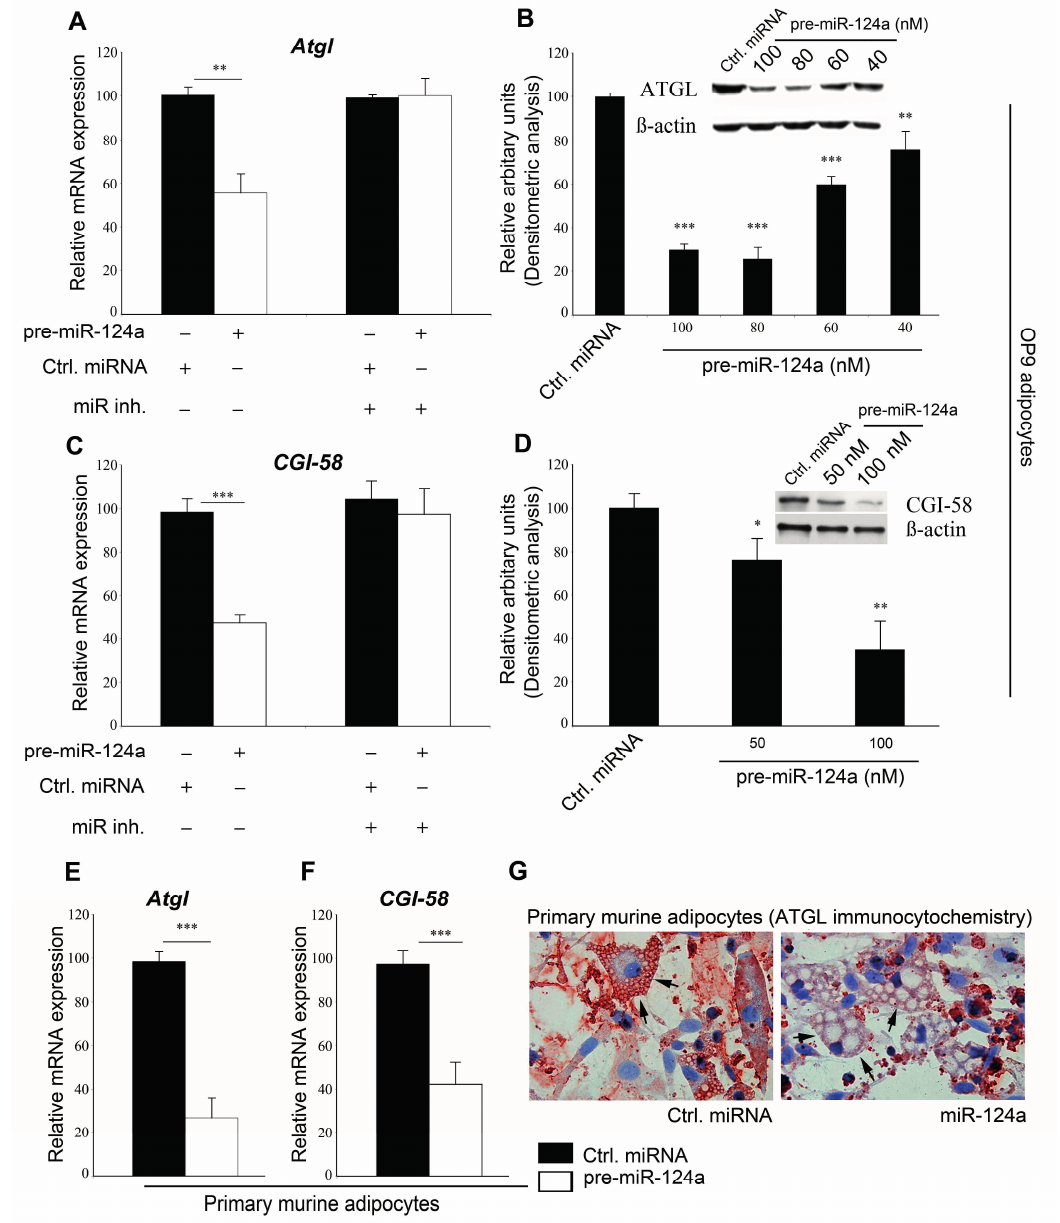
Figure 1. Micro-RNA 124a (miR-124a) regulates expression of adipose triglyceride lipase (ATGL) and CGI-58 . ( A ) pre-miR-124a or control pre-miRNA was co-transfected with or without miR-124a inhibitor in OP9 adipocytes and mRNA- ( A ) or protein-expression ( B ) of Atgl was determined; ( C , D ) Cgi-58 (mRNA)- ( C ) or protein-expression ( D ) was analyzed after co-transfecting pre-miR-124a or control pre-miRNA with or without miR-124a inhibitor into OP9 adipocytes; ( E – G ) Lentiviral particles carrying either control pre-miRNA or miR-124a were transduced into primary mouse adipocytes and qRT-PCR was performed for Atgl (mRNA) ( E ) or Cgi-58 (mRNA) ( F ); Immunocytochemical analysis highlights the lipid bound “active pool” of ATGL. Arrows depict ATGL staining on lipid droplets; ( G ) Data are shown as average ± standard deviation and represent three independent experiments. *** p < 0.001, ** p < 0.01, * p <